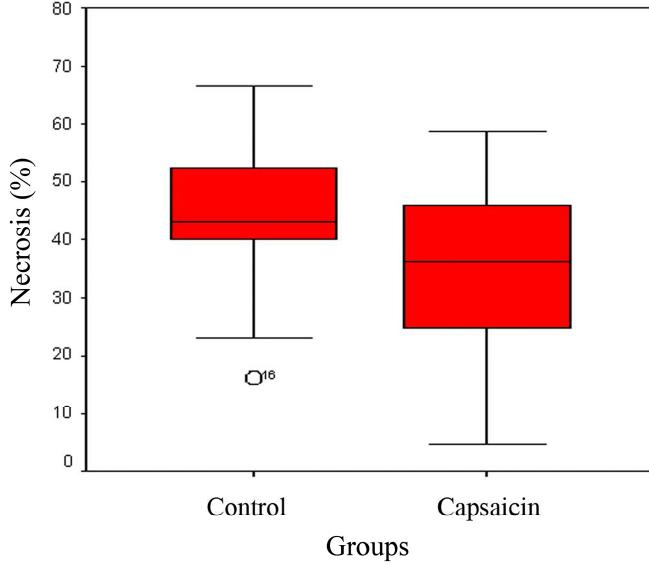
FIGURE 2 - Distribution of the percentage of necrotic area per group Student’s t-test Control group x capsaicin group